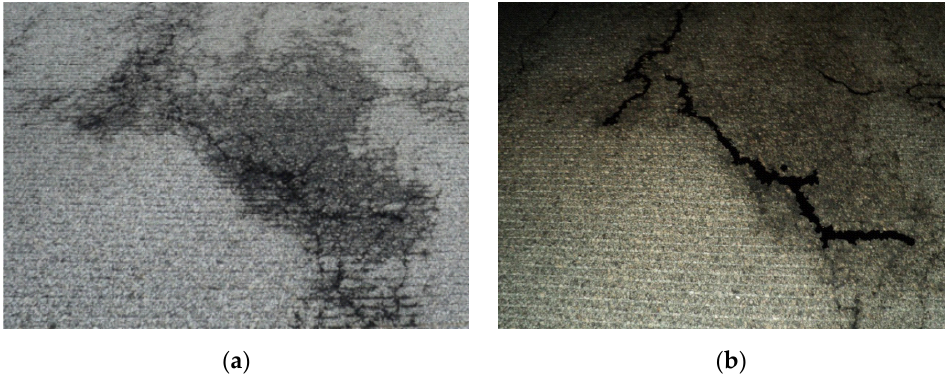
Figure 1. Example showing potential of FOD due to pavement distress and repair; ( a ) High FOD potential, ( b ) low FOD potential.